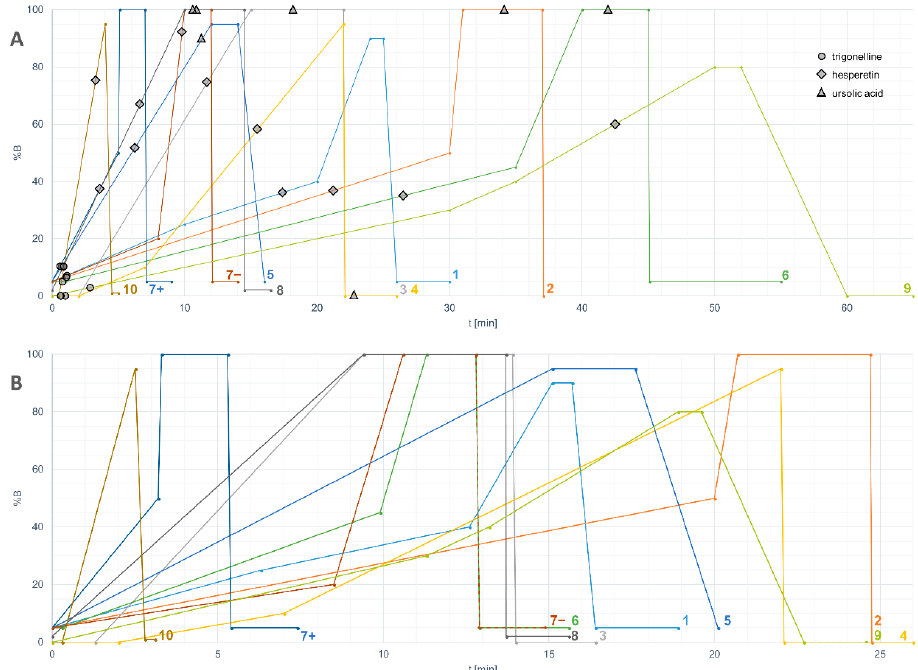
Figure 2. ( a ) HPLC gradients of the participating untargeted LC–MS platforms including the retention times of trigonelline, hesperetin and ursolic acid plotted against the percentage of solvent B. The numbers of the platforms correspond with Table 1. Platform 7 had separate HPLC methods for positive and negative ionization modes; ( b ) The same gradients normalized based on a column with dimensions of 2.1 × 100 mm, particle size 1.7 µm, and flow rate 0.4 mL/min.